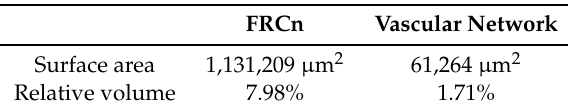
Table 2. Constructed 3D models